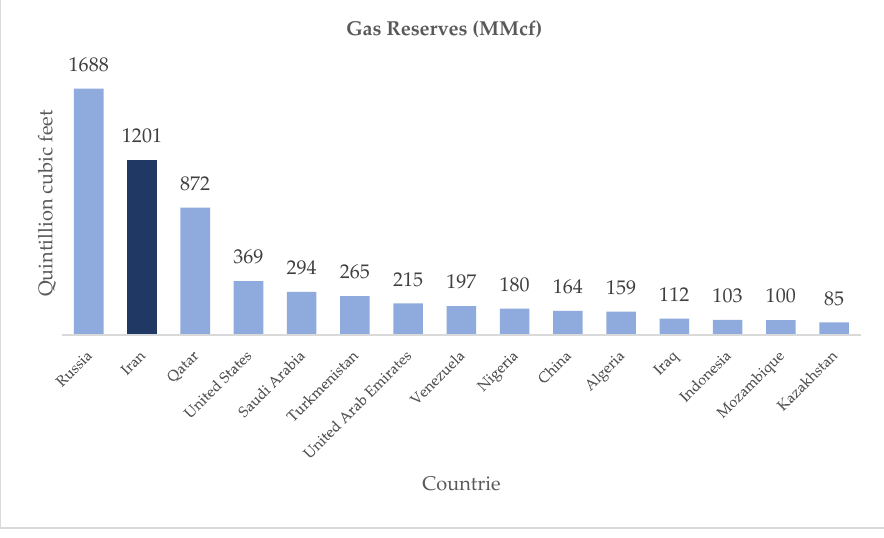
Figure 11. Proven gas reserves in Iraq in 2020, quintillion cubic feet